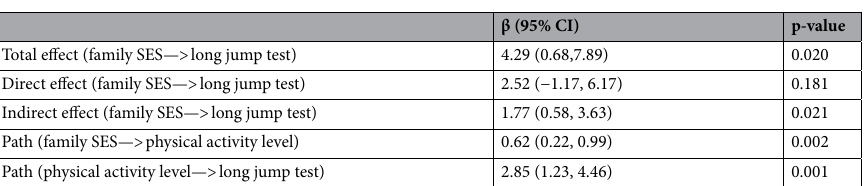
Table 3. Path estimates for the model linking family SES at Wave 1 and standing long-jump test performance at Wave 3. SES socioeconomic status; adjusted for child age, gender, and history of physical diseases.